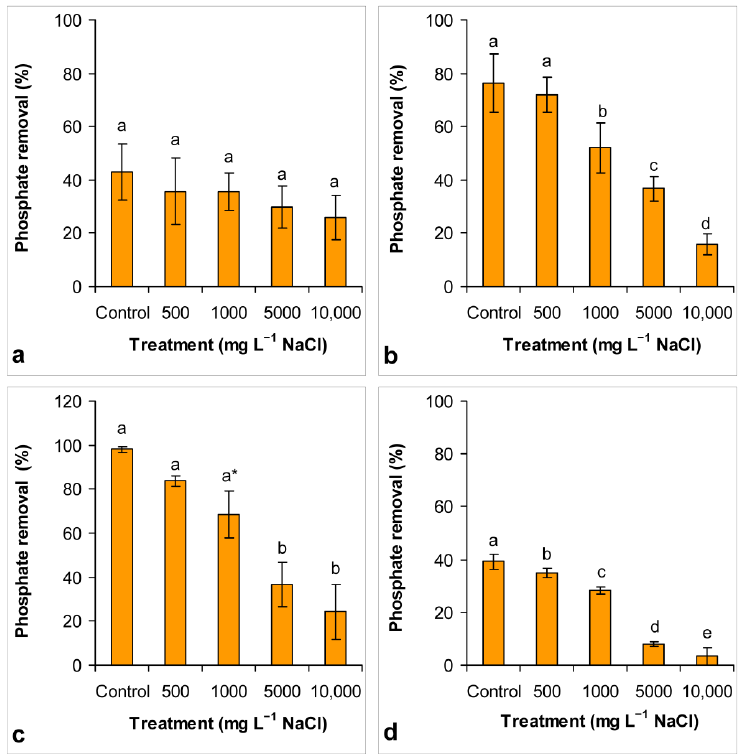
Figure 3. Phosphate removal (%) of control and NaCl-treated Coelastrum morus cultures in: ( a ) HC-LR; ( b ) HC-HR; ( c ) LC-HR and ( d ) LC-LR media. HC: higher content; LC: lower content; HR: higher ratio; LR: lower ratio. Mean values ( n = 3) and standard deviations are plotted. Significant differences ( p < 0.05) are indicated by different lowercase letters. Lowercase letters with asterisks show partial significant difference when it cannot be marked by a different letter.